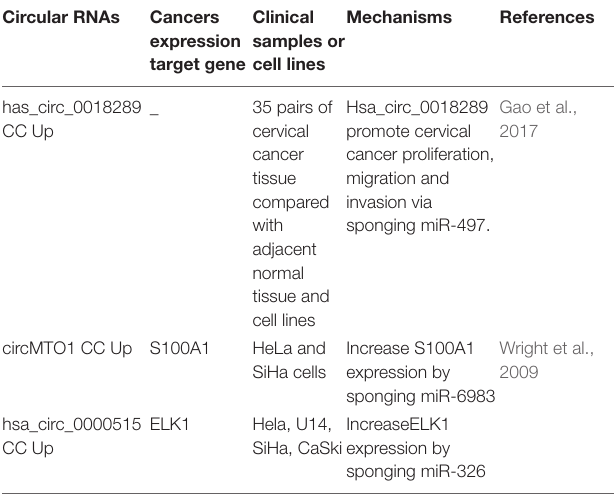
TABLE 1 | The expression and mechanisms of circRNAs in cervical cancer. Circular